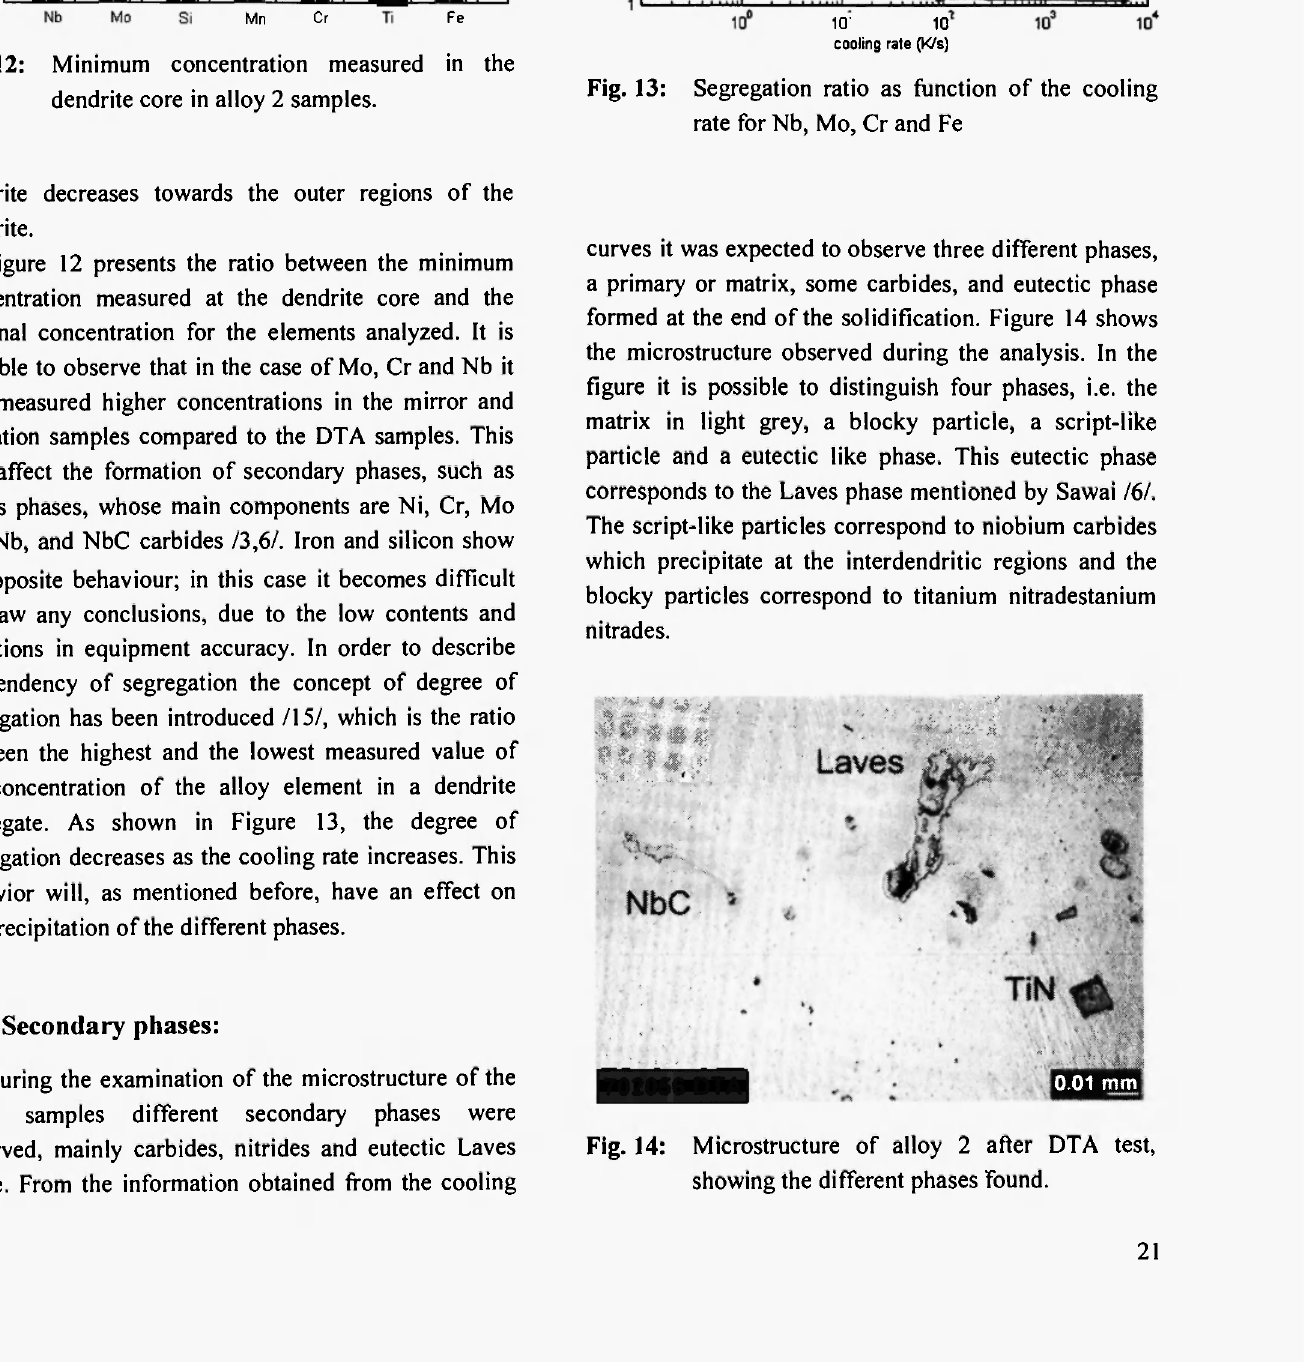
I Fig. 12: Minimum concentration measured in the Fig. 13: Segregation ratio as function of the cooling dendrite core in alloy 2 samples. rate for Nb, Mo, Cr and Fe curves it was expected to observe three different phases, a primary or matrix, some carbides, and eutectic phase formed at the end of the solidification. Figure 14 shows the microstructure observed during the analysis. In the figure it is possible to distinguish four phases, i.e. the matrix in light grey, a blocky particle, a script-like particle and a eutectic like phase. This eutectic phase corresponds to the Laves phase mentioned by Sawai 161. The script-like particles correspond to niobium carbides which precipitate at the interdendritic regions and the blocky particles correspond to titanium nitradestanium nitrades.